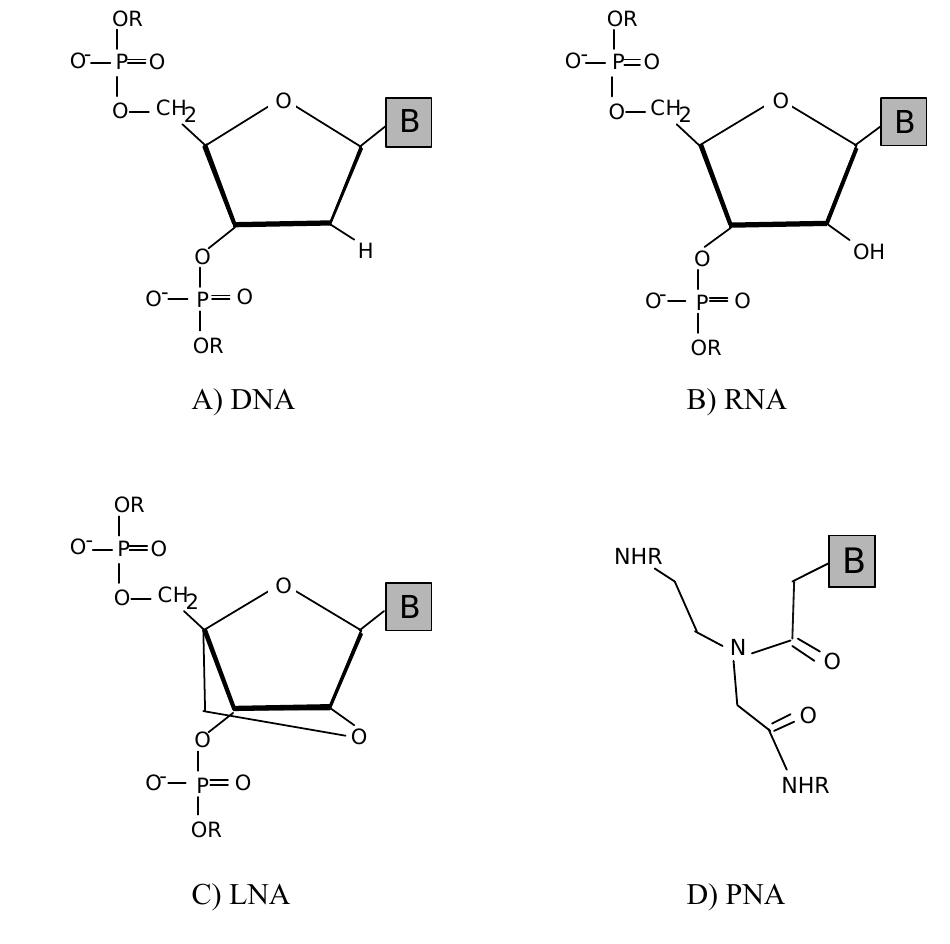
Figure 1. Chemical structures of DNA, RNA and of the DNA mimics, locked nucleic acid (LNA) and peptide nucleic acid